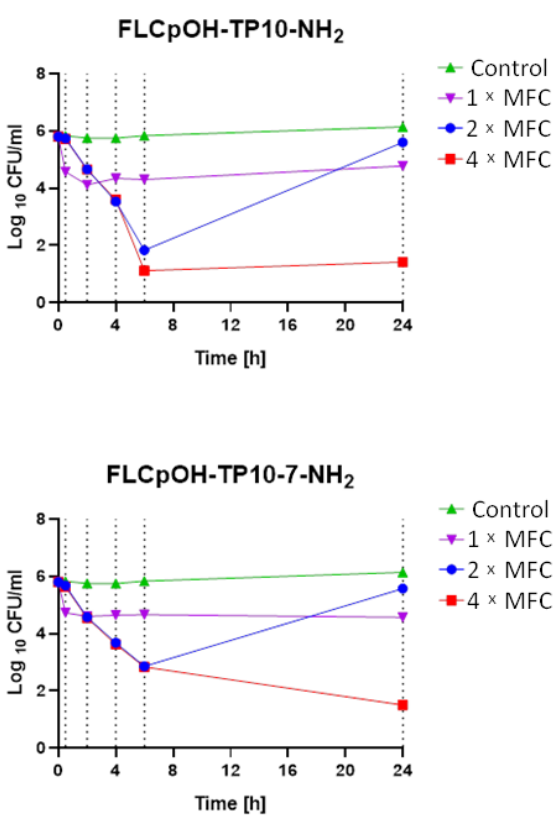
Figure 2. Time-kill determinations for C. albicans strain after treatment with FLCpOH-TP-NH 2 and FLCpOH-TP10-7-NH 2 alone at 1 × MFC, 2 × MFC and 4 × MFC. The x -axis represents the killing time, and the y-axis represents the logarithmic C. albicans SC5314 survival.